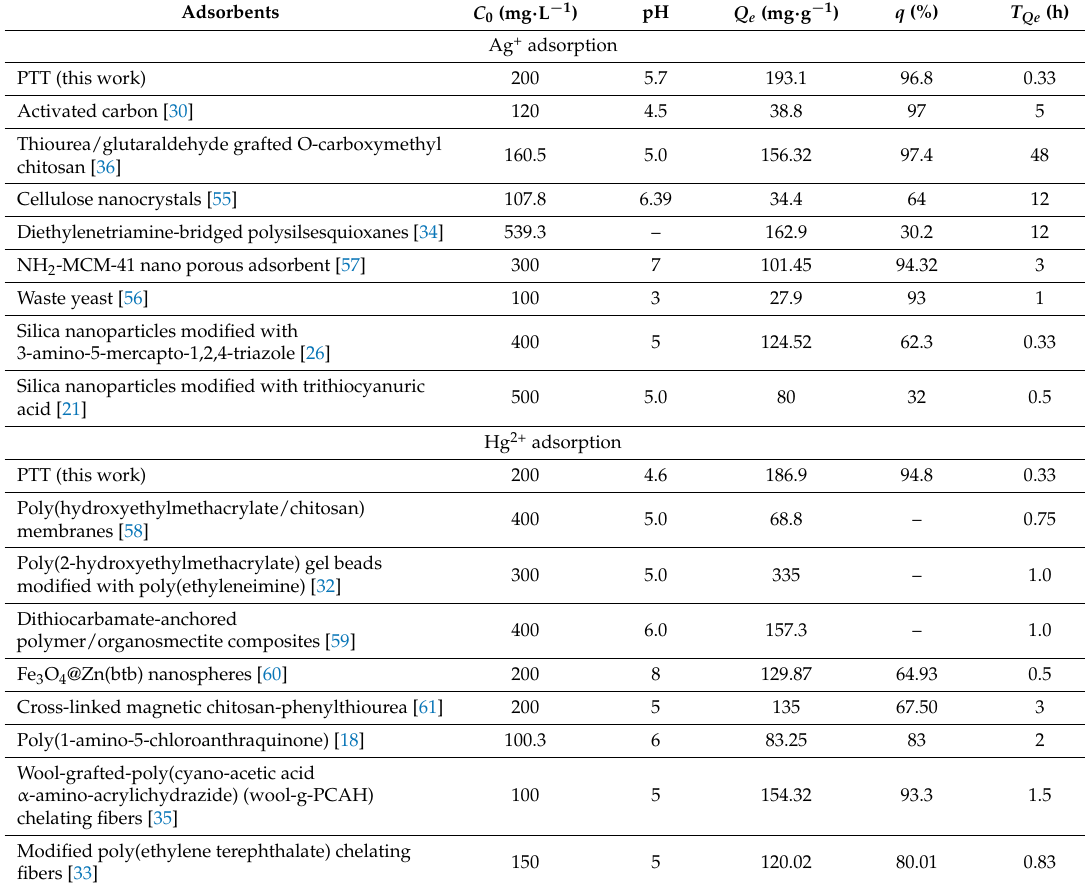
Table 4. Comparison of equilibrium adsorption capacity ( Q e ), adsorption ratio ( q ), and equilibrium time ( T Qe ) of various adsorbents toward Ag + and Hg 2+